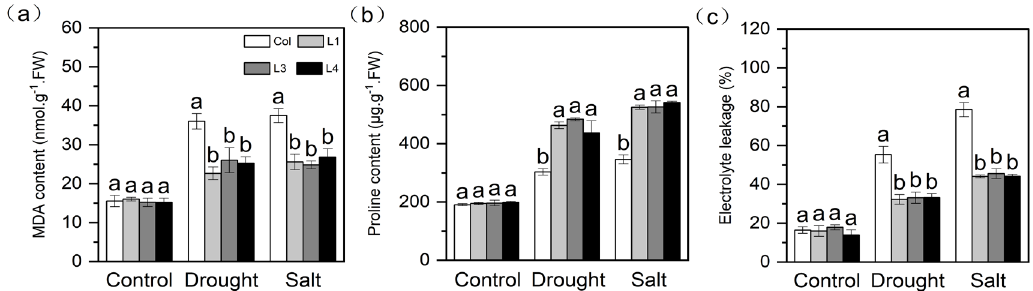
Fig. 5: Analysis of related physiological indicators of transgenic and wild-type Arabidopsis seedlings under osmotic and salt stress. (a) MDA content of transgenic and wild-type Arabidopsis seedlings under osmotic and salt stress. (b) Proline content of transgenic and wild-type Arabidopsis seedlings under osmotic and salt stress. (c) Relative conductivity of transgenic and wild-type A. thaliana seedlings under osmotic and salt stress.